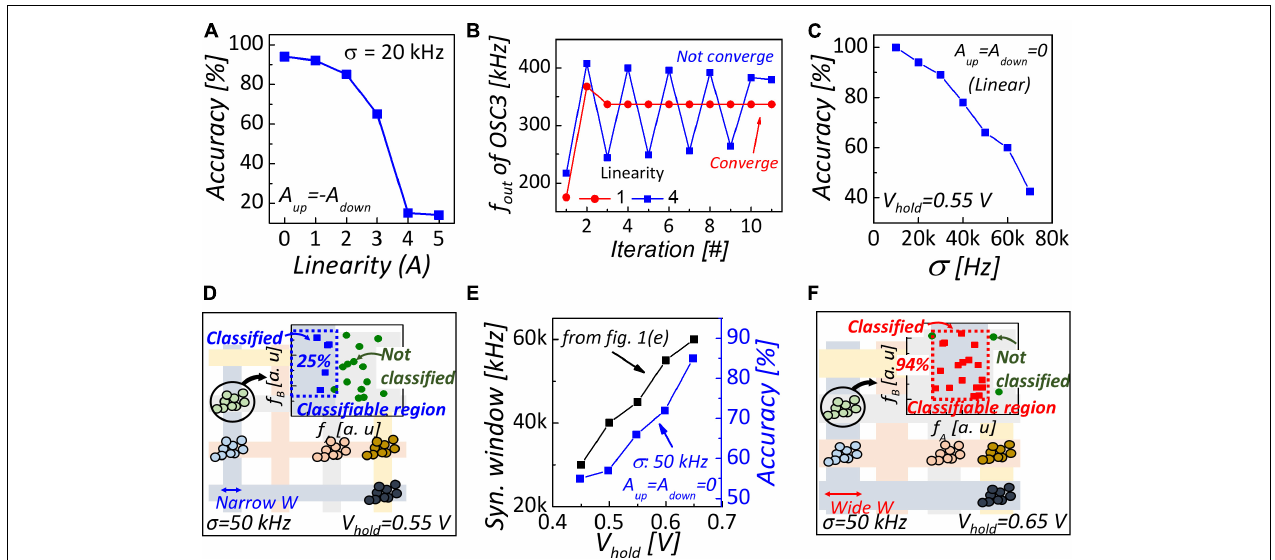
FIGURE 3 | (A) Classification accuracy as a function of non-linearity. The non-linearity of the up and down conductance response is symmetric. (B) Output frequency of 3rd oscillator as a function of training iteration in various non-linearity. (C) Classification accuracy as a function of input variation. To investigate only the effect of input variation, conductance response is linear with the number of pulses. (D) Synchronization map with narrow synchronization window (V hold = 0.55 V); 25% of clustered data was within the classifiable region due to narrow W. (E) Synchronization window and classification accuracy with various hold voltage of NbO 2 device. Synchronization window was simulated in the configuration shown in Figure 1E . (F) Synchronization map with wide synchronization window (V hold = 0.65 V). 94% of clustered data can be classified owing to wide classifiable